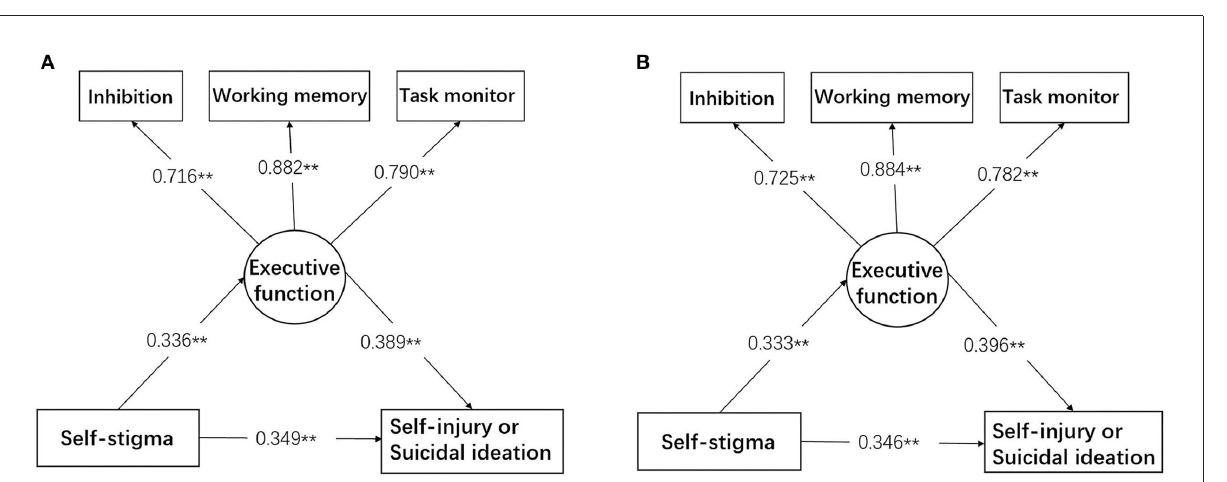
FIGURE1 Mediation model in which the relationship between self-stigma and self-injury or suicidal ideation was mediated by the three core executive functions, namely, inhibition, working memory, and task monitor. (A) Shows the unadjusted model. (B) Shows the model adjusted by age, education level, and occupational status. ** p <